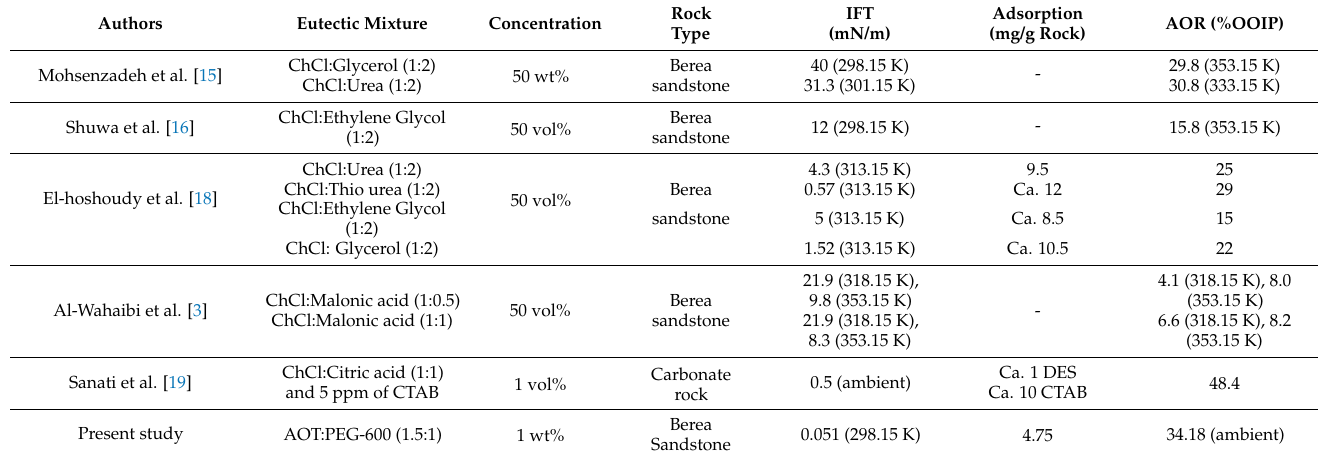
Table 7. Comparison of results obtained in this work and in previous